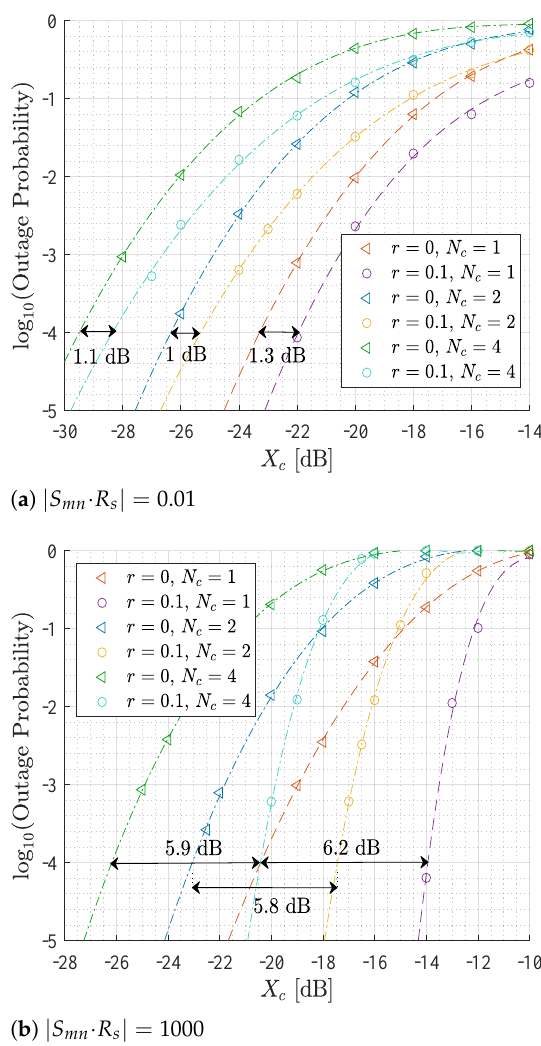
Figure 4. OP as a function of the ICXT level per interfering core, for 1, 2, and 4 interfering cores with PAM4 format, for ( a ) | S mn · R s | = 0.01 and ( b ) | S mn · R s | = 1000, for r = 0 and r = 0.1. The dashed lines represent a cubic interpolation of log 10